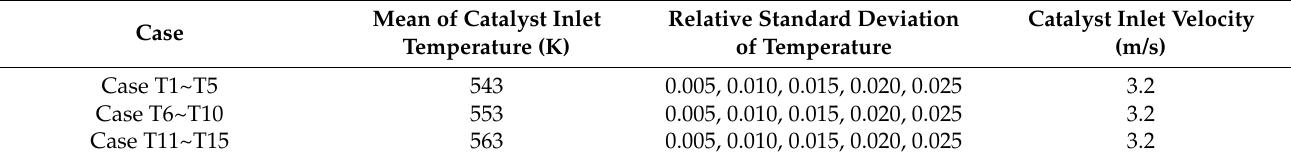
Table 2. Design of the temperature random field (different averaged values of temperature).